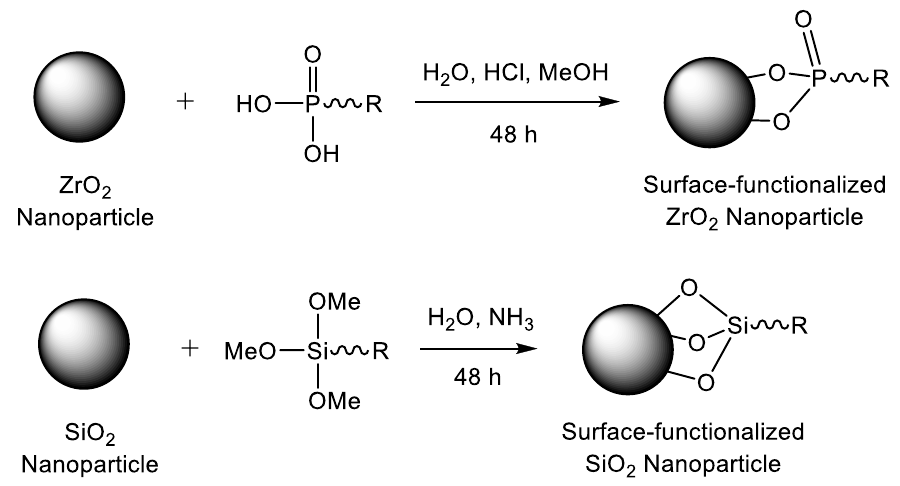
Figure 1. Surface-functionalization of the ZrO 2 and SiO 2 nanoparticles. For details see supplementary materials. Table 1. List of the studied surface modifications.